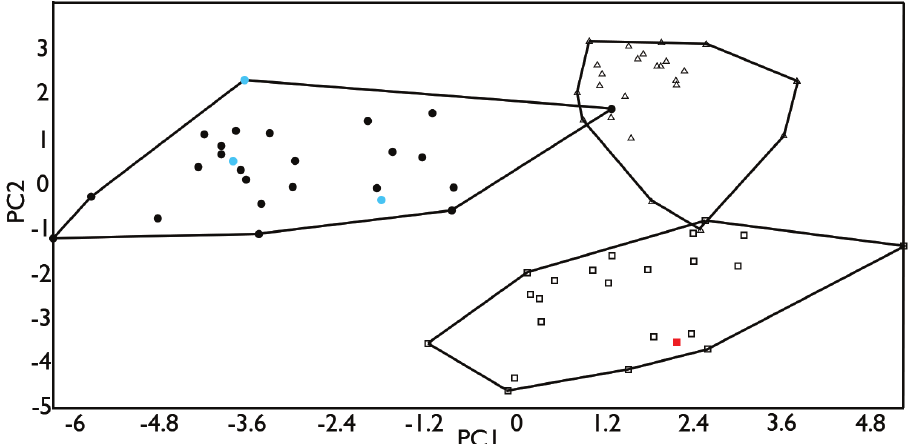
Figure 2. Ordination diagram of principal components 1 and 2 from the PCA of morphological data for males. Circles represent specimens from Tamaulipas, Hidalgo, and northern and central Veracruz; triangles represent specimens from southern Veracruz and western Tabasco; squares represent specimens from the Yucatan Peninsula. Blue circles represent specimens from near the type locality of Anolis sericeus . The red square indicates the syntype specimen of A. ustus